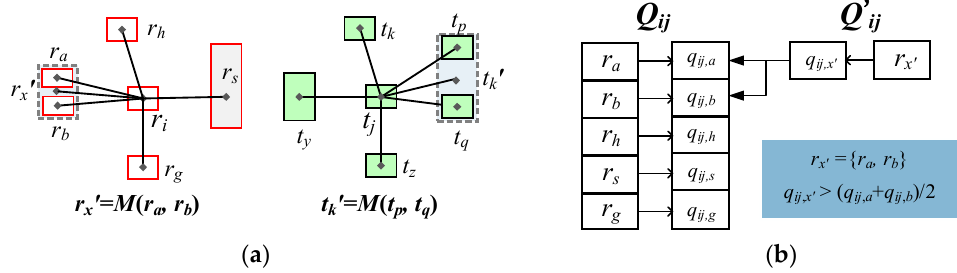
Figure 6. Integrating the sub-support indexes of neighboring individual objects and pattern combinations into a total support index: ( a ) neighboring individual objects and pattern combinations of ( r i , t j ); ( b ) integrating all sub-support indexes into a total support index. Once the total support indexes of all candidate-matching pairs were determined, the iteration of the geo-similarity matching matrix was executed according to Formula (9) [24]. The relaxation labelling process will continue until the probability differences between two iterations are less than a predefined threshold δ